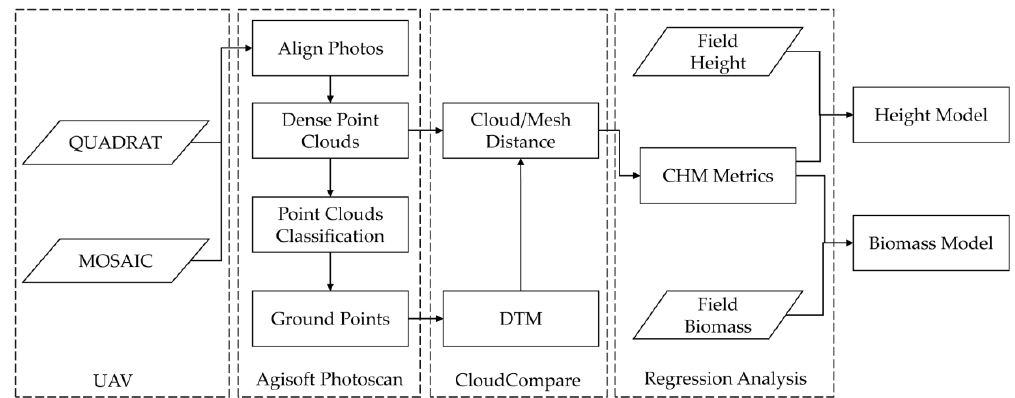
Figure 2. The flowchart of estimation of grassland canopy height and aboveground biomass.